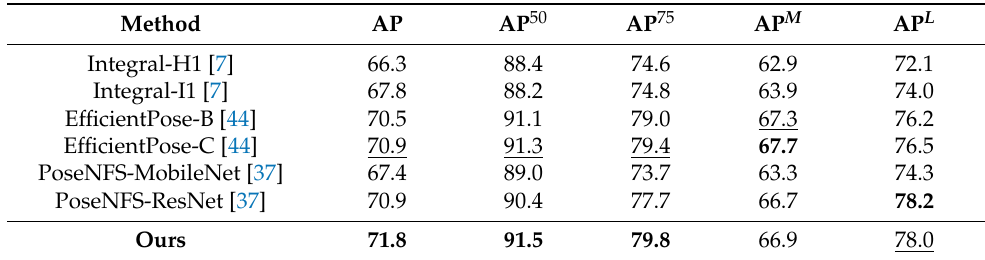
Ours Table 5. Comparison results on COCO test-dev. Higher values are better, with the best being indicated by bold font, and the second best being